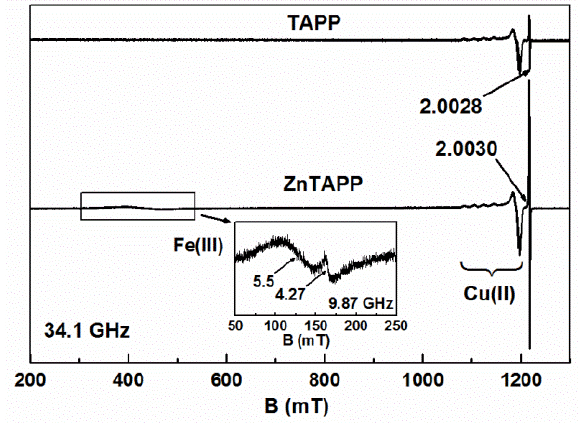
Figure 5. Q-band EPR spectra of the TAPP ( top ) and ZnTAPP ( bottom ) samples measured at RT. Inset: detailed view of the Fe(III) signals in the X-band EPR spectrum of the ZnTAPP sample.